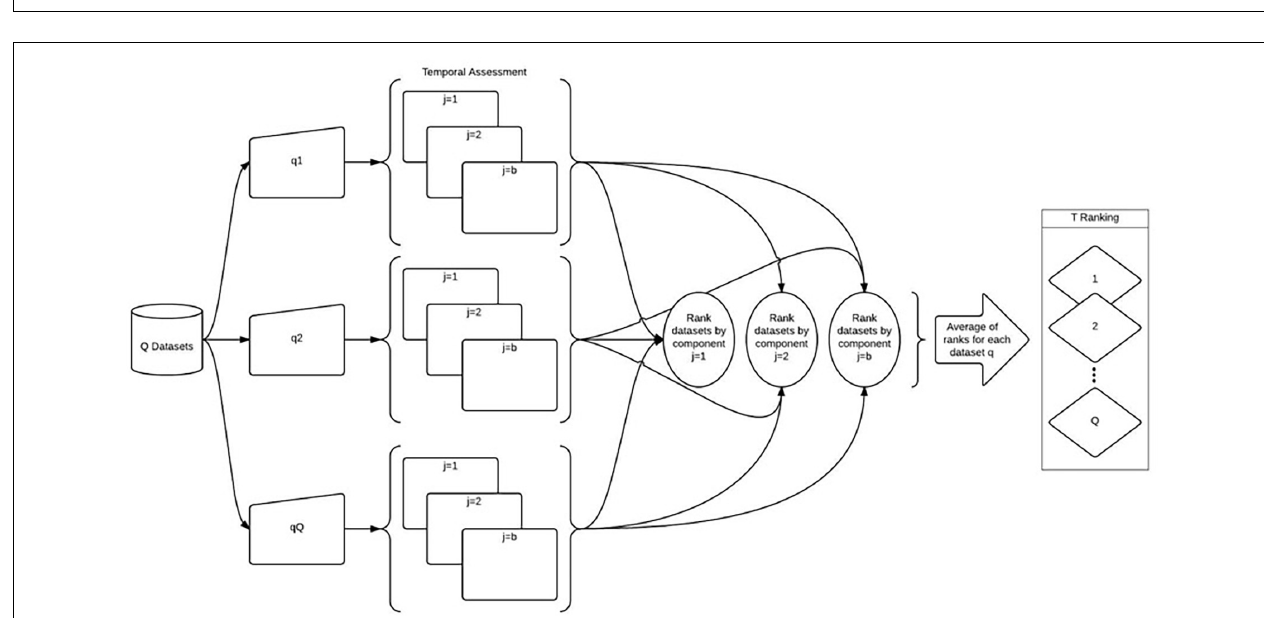
FIGURE 2 | Temporal Scale (T) component, adapted from Shimizu